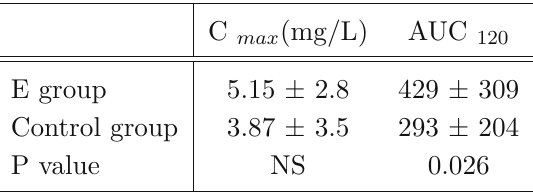
Table 3 Peak paracetamol plasma levels (C max ), and the area under the paracetamol concentration curve from 0 to 120 min (AUC 120 ) in the control group C and E group (early postoperative gastric supply of